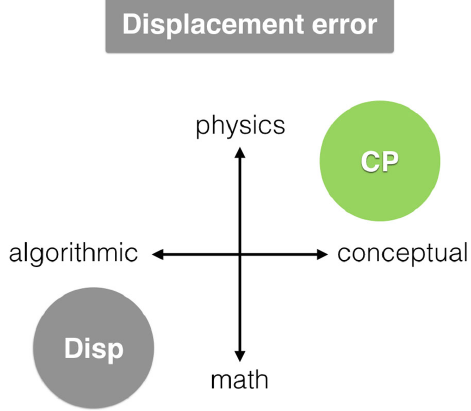
FIG. 3. Displacement error: Displacement error (Disp). This student should be in CP, but is in algorithmic math.